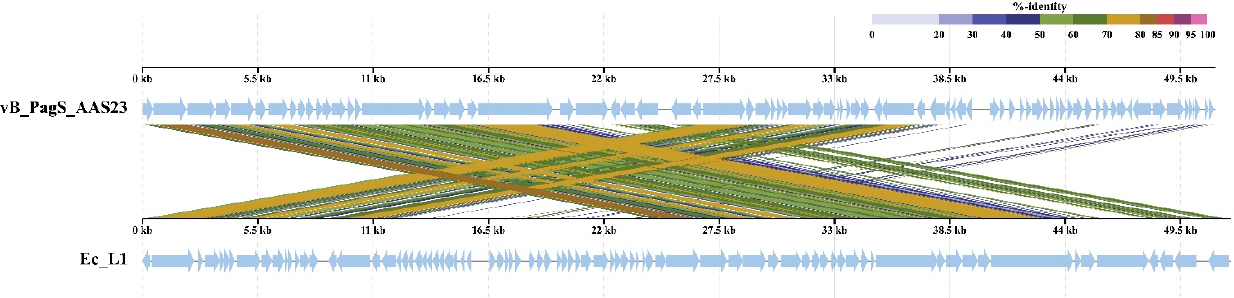
Figure 6. ViPTree generated whole-proteome alignment of Pantoea phage vB_PagS_AAS23 and Enterobacter phage Ec_L1. Colored lines in the alignment indicate tBLASTx results (E-value < 0.01). Positions of each sequence are automatically adjusted (i.e., circularly permuted and reverse stranded) for clear representation of collinearity between